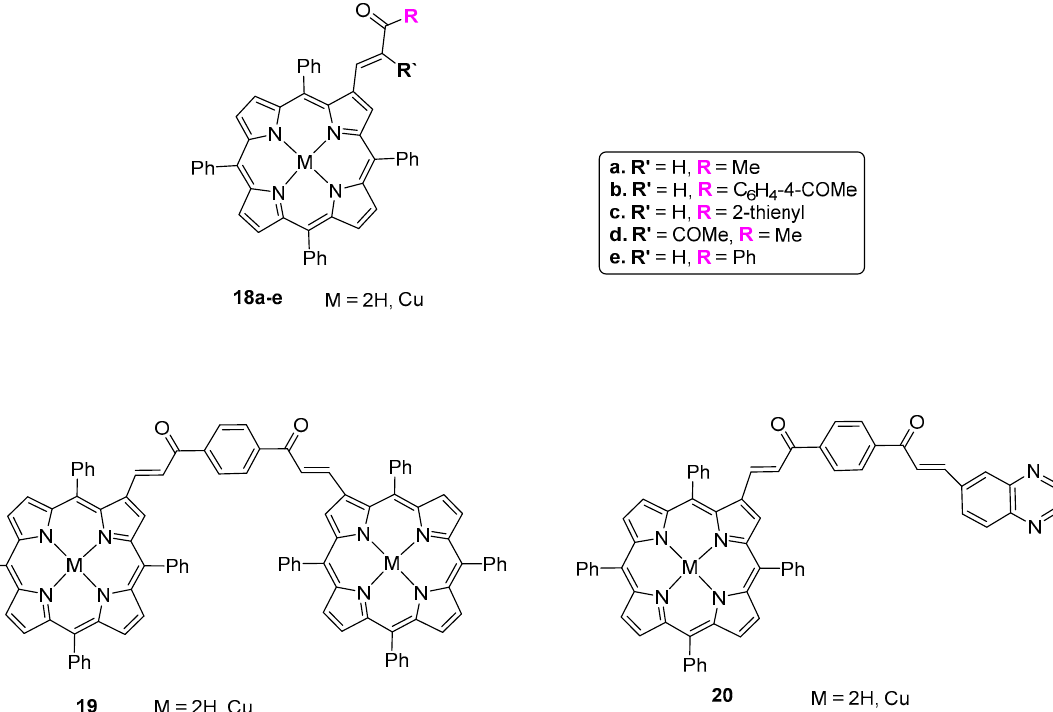
Table 2. Yields of the products obtained in the reaction of β -CHOTPP 3 with ketones 21 . Entry